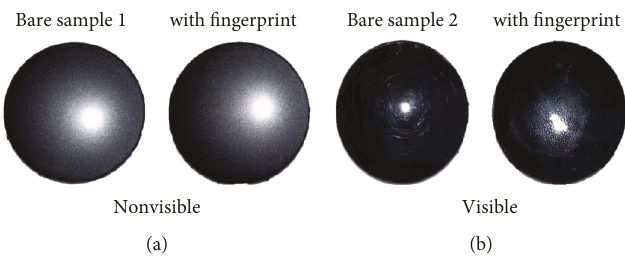
Figure 5: IML1 (a) and IML5 (b) views before and after the deposition of the arti fi cial fi